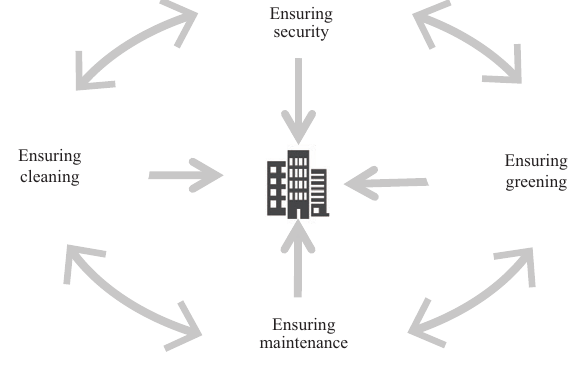
Figure 2. Logical structure diagram of the 4E mode of traditional property